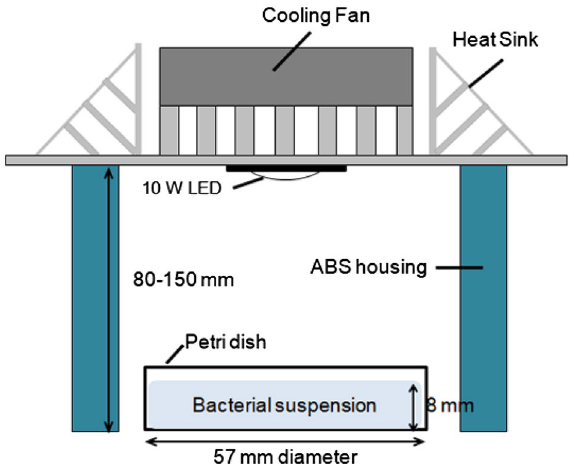
Figure 6. Experimental setup to check the growth of E. coli O157:H7 under the influence of different wavelengths